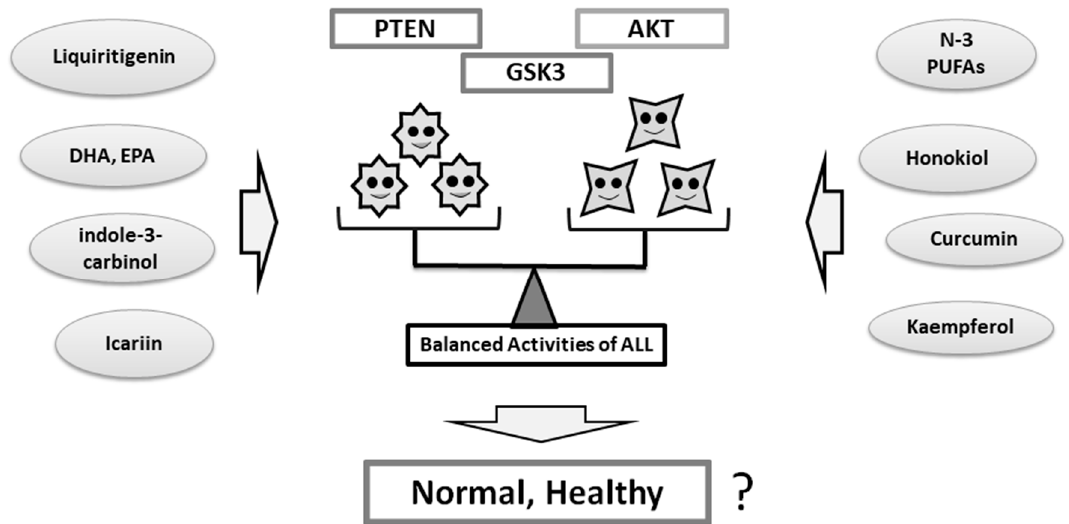
Figure 3. The balance of PTEN, AKT, and GSK3 in the meaning of their functions may be important for individual psychiatric health. Several food and/or dietary components may provide improved balance of the signaling via the modulation of the functional activities.